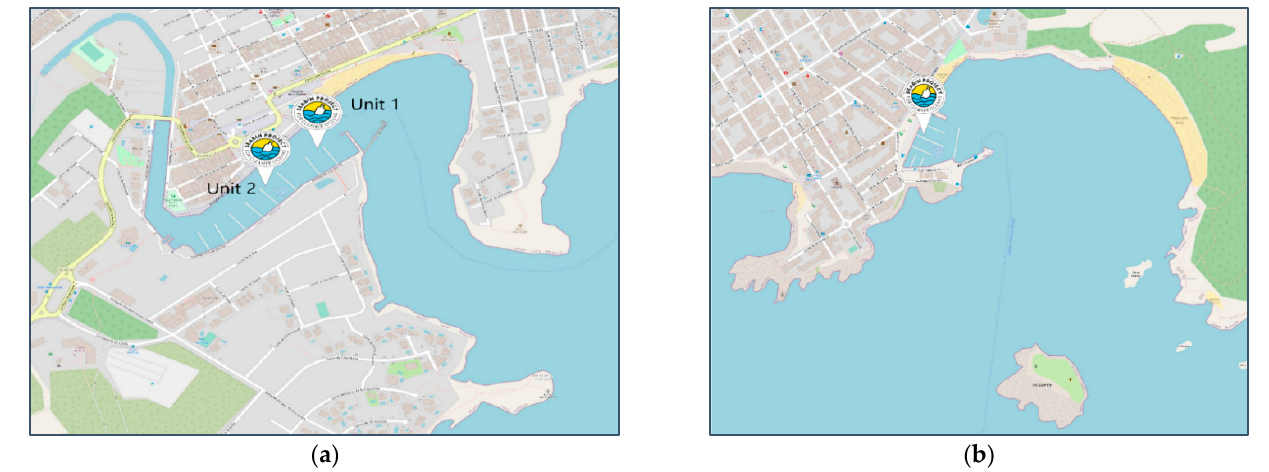
Figure 2. ( a ) Seabin positions in Port of Cristo, ( b ) Seabin position in Port of Colonia de Sant Jordi. Source: Adapted by the authors, based on Open Street Map.